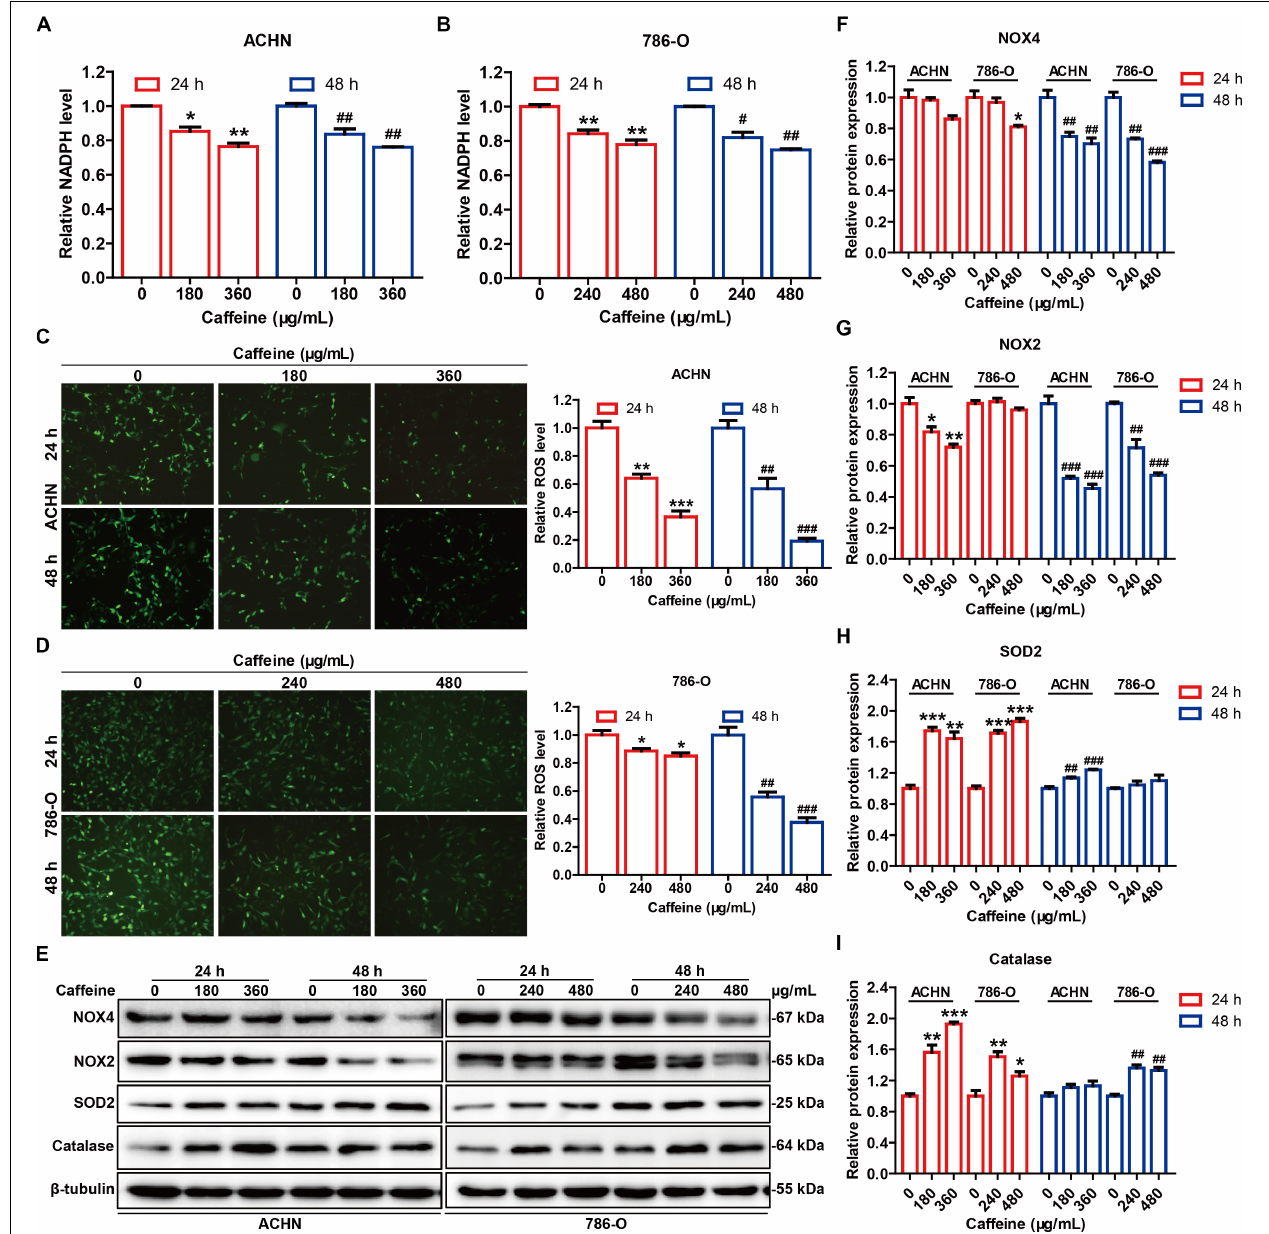
FIGURE 5 | Caffeine disrupts G6PDH-mediated redox homeostasis in RCC cells. NADPH levels in ACHN (A) and 786-O (B) cells treated with caffeine, as detected using a NADP/NADPH Quantification Kit. * P < 0.05 and ** P < 0.01 versus the control group at 24 h; # P < 0.05 and ## P < 0.01 versus the control group at 48 h. Intracellular ROS accumulation in ACHN (C) and 786-O (D) cells treated with caffeine, as determined using a general oxidative stress indicator (CM-H 2 DCFDA). Images were captured at × 200 magnification. * P < 0.05, ** P < 0.01, and *** P < 0.001 versus the control group at 24 h; ## P < 0.01 and ### P < 0.001 versus the control group at 48 h. (E) Expression levels of redox-related proteins in ACHN and 786-O cells treated with caffeine, as determined by western blotting. The gray densities of the bands corresponding to NOX4 (F) , NOX2 (G) , SOD2 (H) , and catalase (I) proteins were quantified using AlphaView software. * P < 0.05, ** P < 0.01, and *** P < 0.001 versus the control group at 24 h; ## P < 0.01 and ### P < 0.001 versus the control group at 48 h. Representative images are displayed. Data are shown as means ± SEM of triplicated experiments.